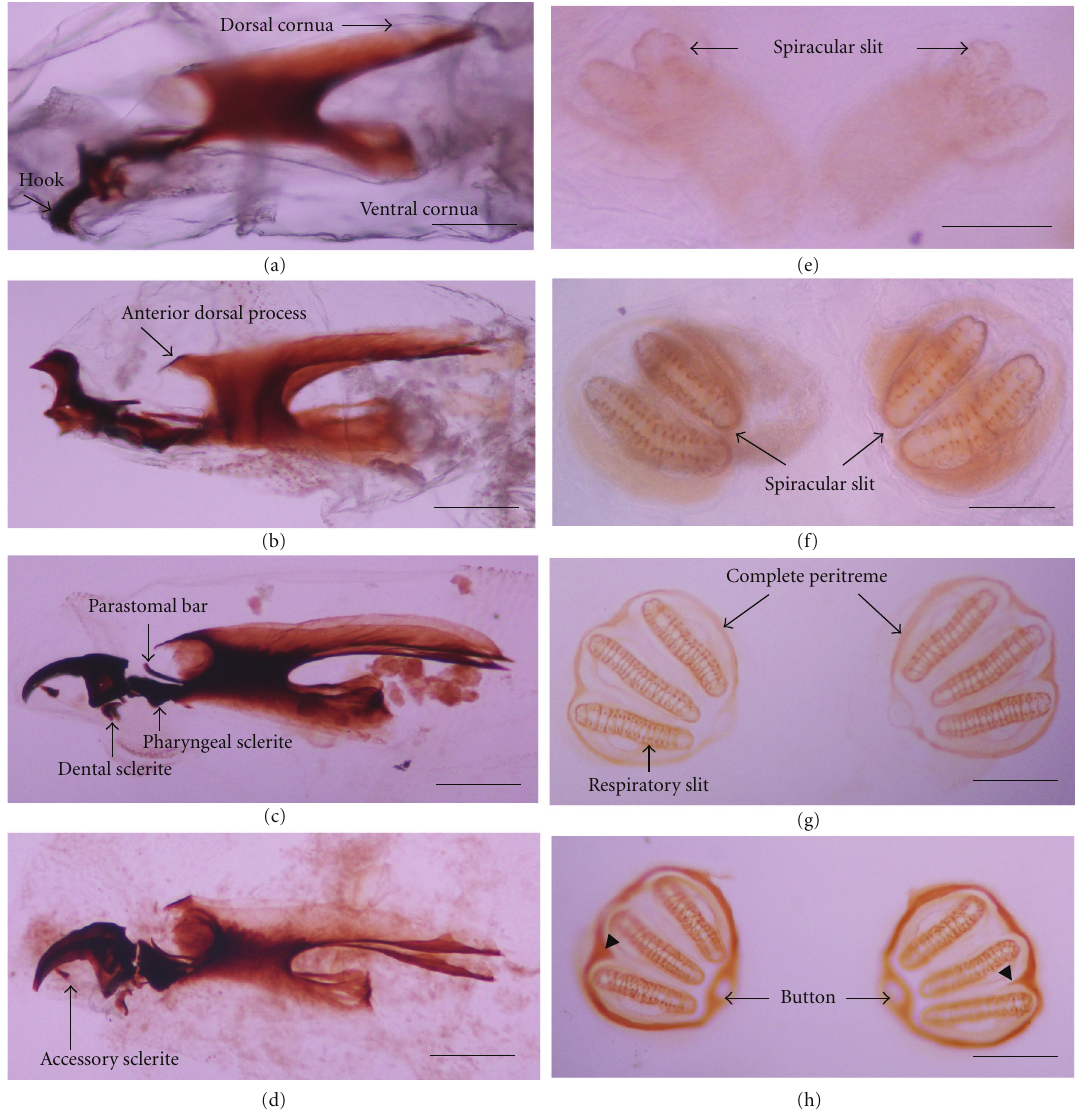
Table 2: Comparison of distinctive features of the 1st, 2nd, and 3rd instar larvae of Hemipyrellia ligurriens. Character 1st instar 2nd instar 3rd instar Cephalopharyngeal skeletal: accessory sclerite of cephalopharyngeal skeletal Absent Absent Present Posterior spiracle: button of posterior spiracle Absent Absent Present Weakly pigmented; Highly pigmented; Very weakly pigmented; incomplete peritreme peritreme of posterior spiracle complete peritreme with incomplete peritreme without an interslit an interslit projection projection Number of spiracular slit 2 slits merging ventrally 2 separated slits 3 separated